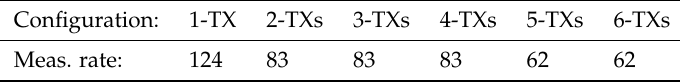
Table 2. Measurement rates (sample/s) for all configurations.